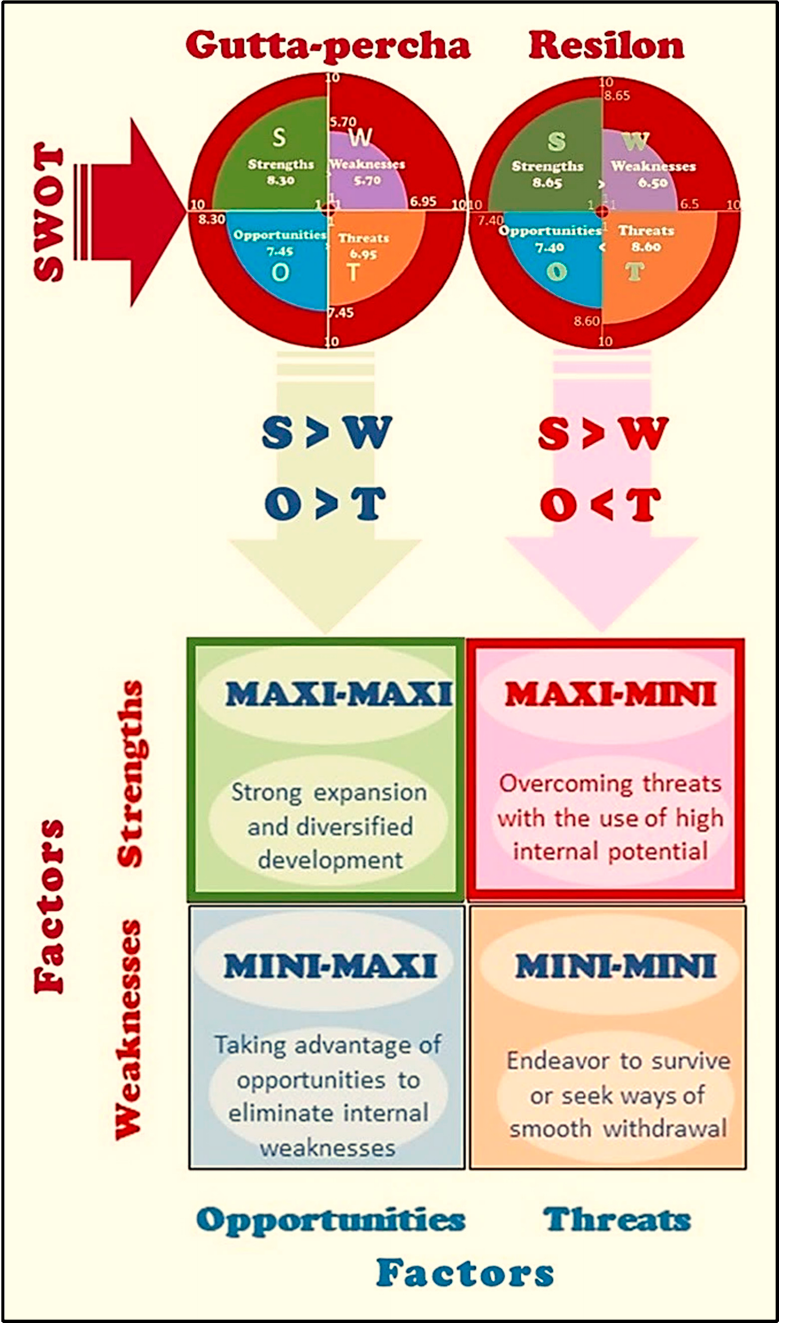
Figure 33. Results of contextual analysis SWOT (strengths–weaknesses–opportunities–threats) concerning material based on gutta ‐ percha and resilon as the filling materials and adequate development strategies for these filling materials MAXI ‐ MAXI and MAXI ‐ MINI from among four possible.